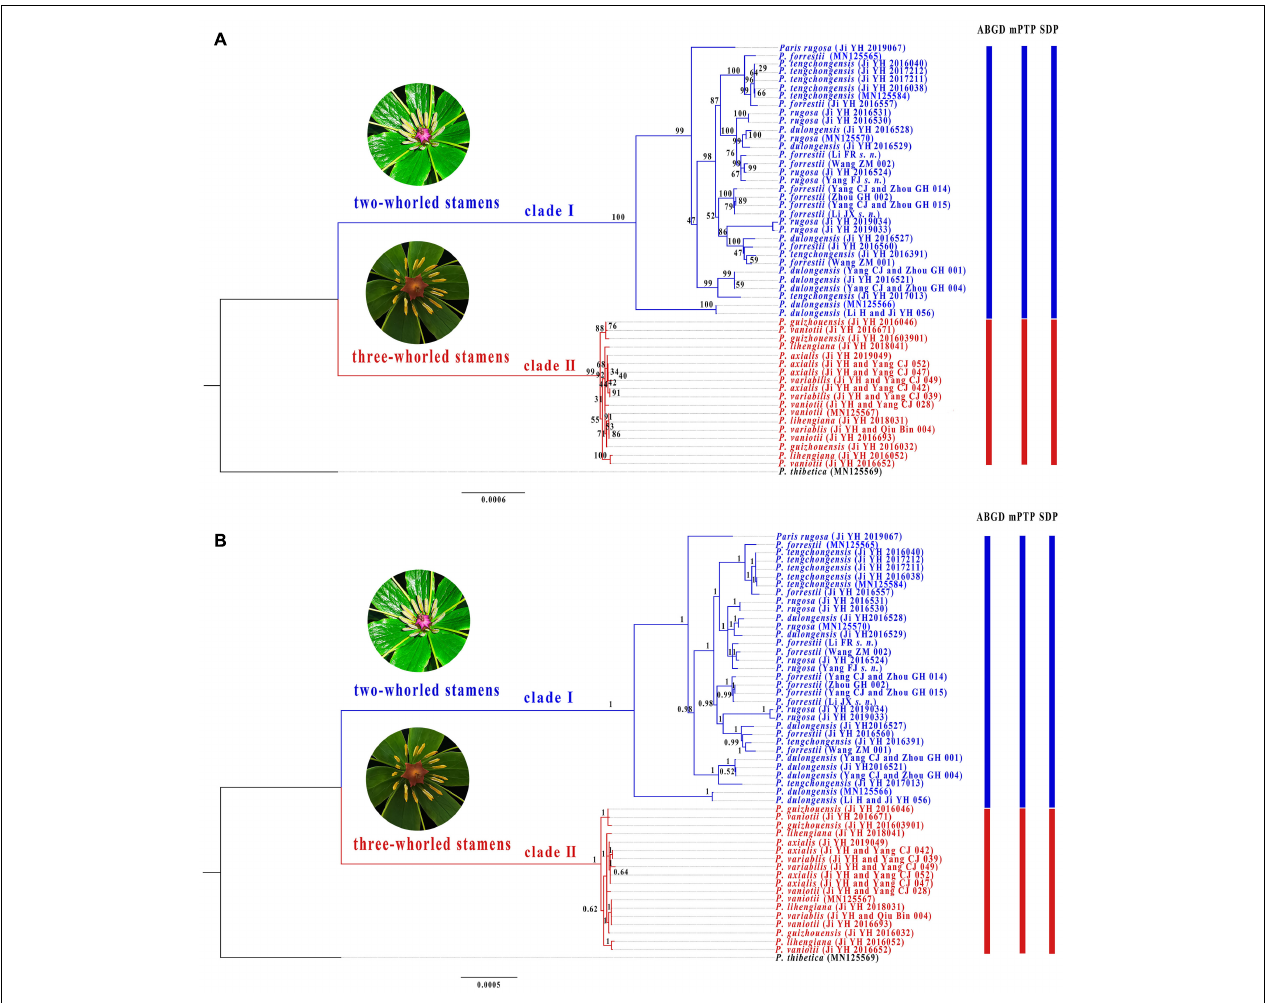
FIGURE 3 | Phylogenetic tree of Paris section Axiparis based on Maximum likelihood (ML, A ) and Bayesian inference (BI, B ) analyses of complete plastomes. Numbers above branches indicate ML bootstrap (BS) percentages and Bayesian posterior probabilities (PP). Species delimitation schemes proposed by automatic barcode gap discovery (ABGD), multi-rate Poisson tree processes model (mPTP), and species delimitation plugin (SDP) of Geneious are reflected on the tree